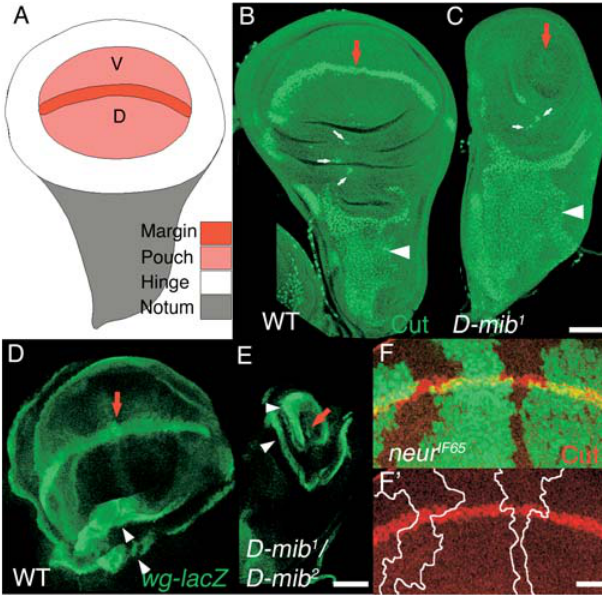
Figure 2. The D-mib and neur Genes Have Distinct Functions during Wing Development (A–E) Wing imaginal discs (B–E) from wild-type (B and D), D-mib 1 (C), and D-mib 1 /D-mib 2 (E) third instar larvae stained for Cut (B and C) and wg-lacZ (D and E). D-mib mutant discs showed a dramatically reduced size of the wing pouch (see diagram in [A] showing the different regions of the wing imaginal disc; V, ventral; D, dorsal), as well as a complete loss of Cut and wg-lacZ (red arrows in [B–E]) expression at the wing margin. Expression of wg-lacZ in the hinge region (arrowheads in [D] and [E]) and the accumulation of Cut in sensory cells (small arrows in [B] and [C]) and muscle precursor cells (large arrowheads in [B] and [C]) appeared to be largely unaffected). (FandF 9 )ExpressionofCut(red)atthewingmarginwasnotaffectedby the completeloss of neur activity in neur 1F65 mutant clones (indicated by the loss of the nuclear green fluorescent protein [GFP] marker, in green). Bar is 50 l m in (B–E) and 20 l m in (F and F 9 ). DOI: 10.1371/journal.pbio.0030096.g002